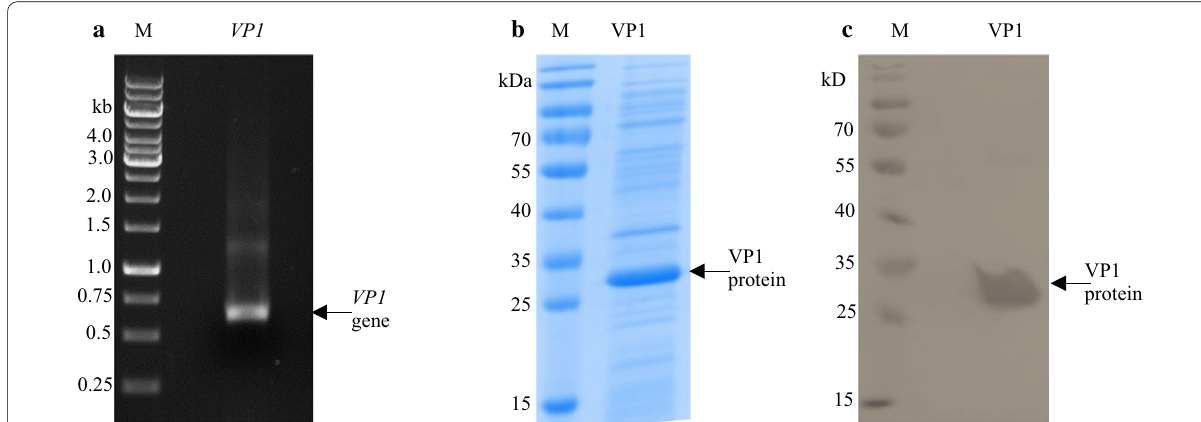
Fig. 1 Expression of the VP1 gene of the FMDV SAT2/ZIM/7/83 in E. coli BL21 (DE3) cells. The 615-bp VP1 gene was PCR amplified and electrophoresed on a 1.5% agarose gel ( a ). The GeneRuler TM 1 kb DNA Ladder (Thermo Scientific) was loaded as a marker (M). The recombinant VP1 protein was produced by EC-VP1 after induction with a final concentration of 1 mM IPTG in EnPresso B medium ( b ). After cell lysis with BPER, the insoluble fraction was analyzed on a 15% SDS–polyacrylamide gel, the expressed VP1 protein is indicated with an arrow. The PageRuler TM Prestained Protein Ladder (Thermo Fischer Scientific) was included as a marker in lanes M in b , c . The N-terminal histidine tagged VP1 protein was detected with anti-histidine antibodies by western blot analysis among insoluble proteins that were separated under denaturing conditions and transferred to a PVDF membrane ( c